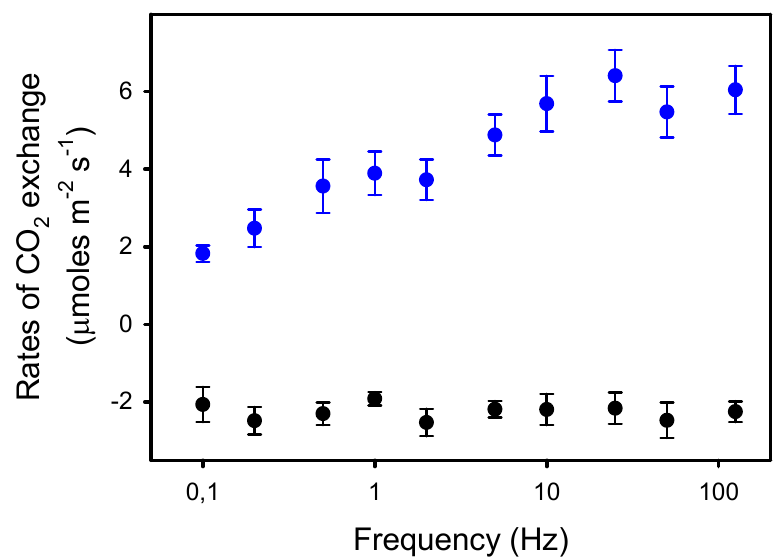
Figure 1. Rates of net photosynthesis P n (blue dots) in sunflower leaves exposed to pulsed lights of frequencies ranging from 125 to 0.1 Hz. The duty ratio was 25% and the averaged light intensity was 575 μmoles photons m −2 s −1 . The black dots represent the rates of dark respiration R d (-P n dark ) measured between the 8–10 min periods of pulsed lights of different frequencies. The data presented are the means of four independent measurements and the errors bars are the S.E.M. Note the logarithmic scale for the x -axis.